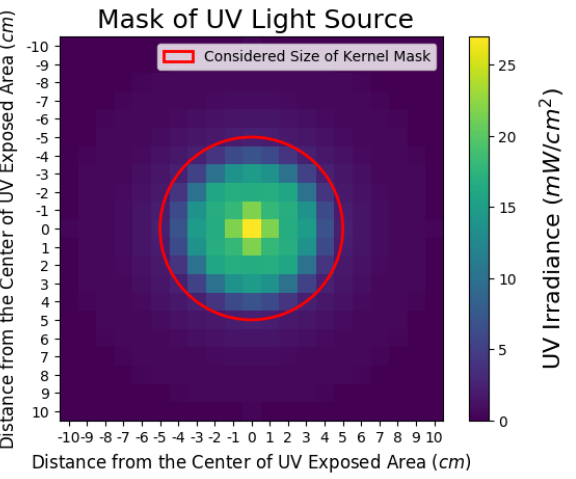
Figure 12. Kernel mask representation of the UV